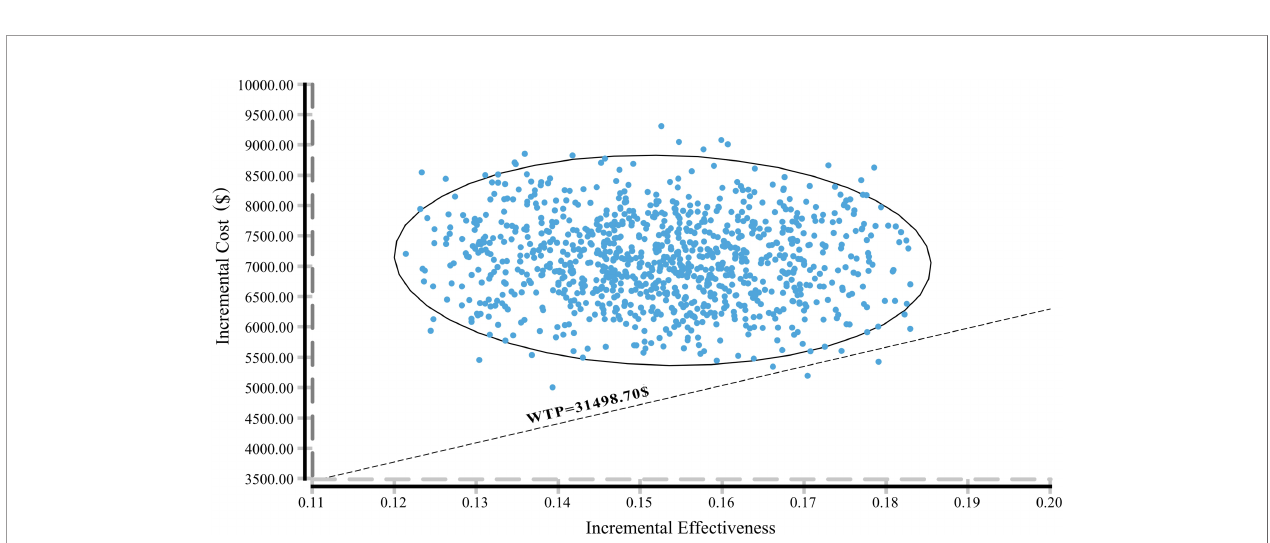
FIGURE 5 | A probabilistic scatter plot of the ICER between the CTP and PTP group. Each dot represents the ICER for 1 simulation. An ellipse means 95% con fi dence interval. Dots that are located below the ICER threshold represent cost-effective simulations. CTP, camrelizumab-chemotherapy; PTP, placebo- chemotherapy; WTP, willingness-to-pay, ICER, incremental cost-effectiveness